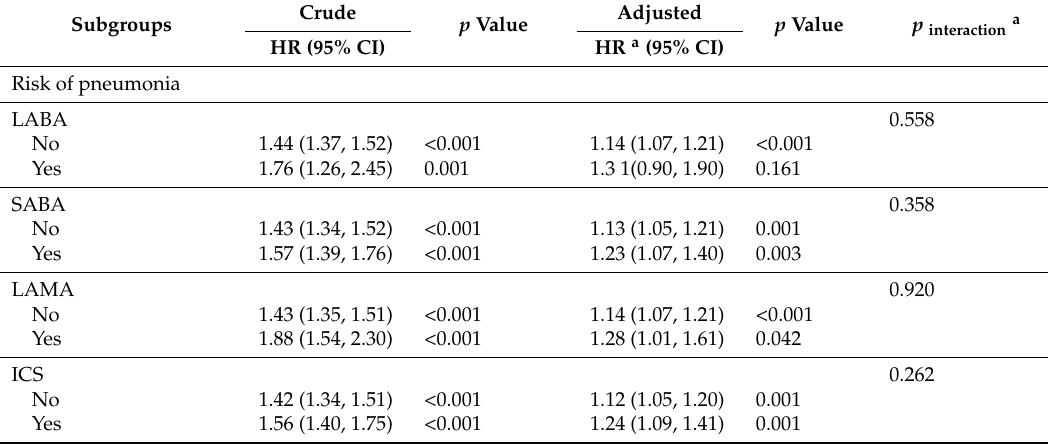
Table 4. Subgroup analysis of risk of pneumonia among COPD patients with AF and matched non-AF